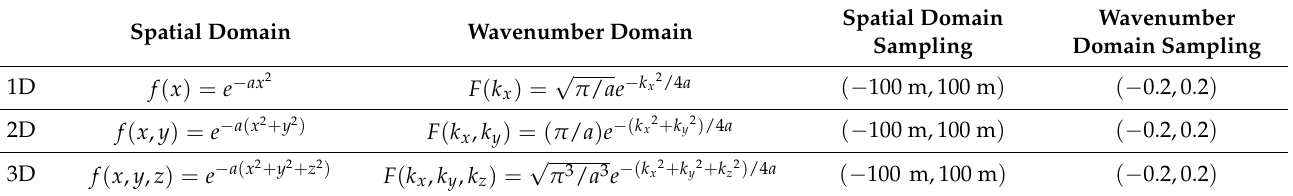
Table 1. Gaussian function expression and sampling range in spatial domain and wavenumber